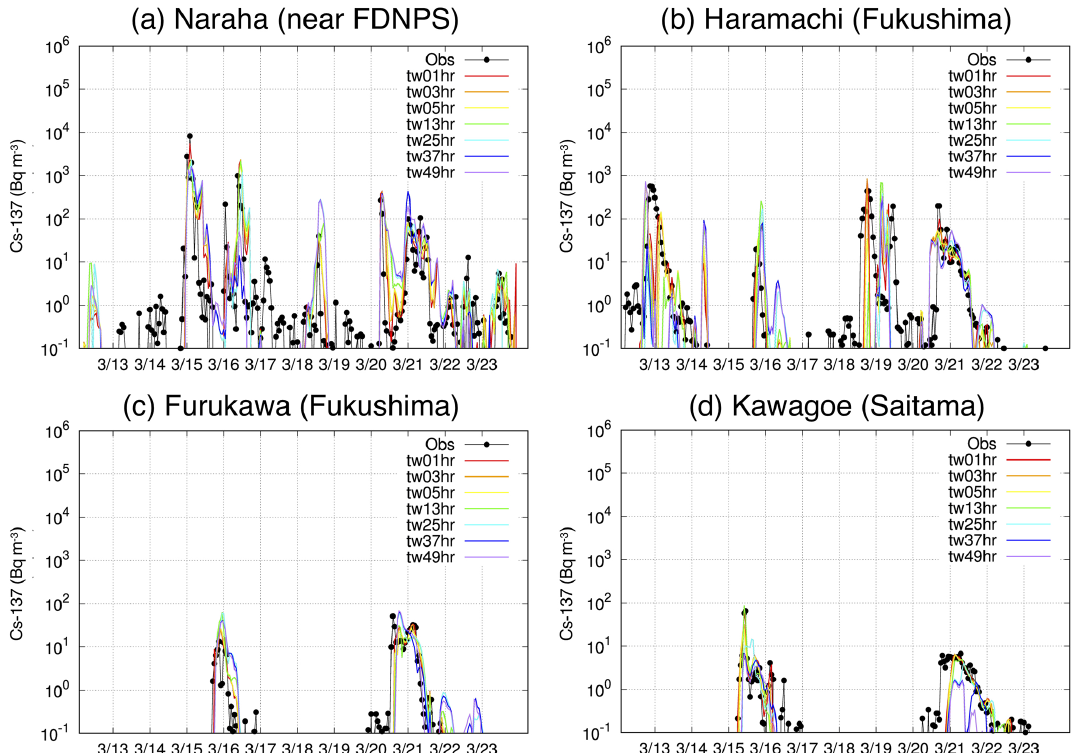
Figure 8. Same as Fig. 2 except for the use of the ensemble results with various time windows ranging from 1h (tw01hr) to 49h